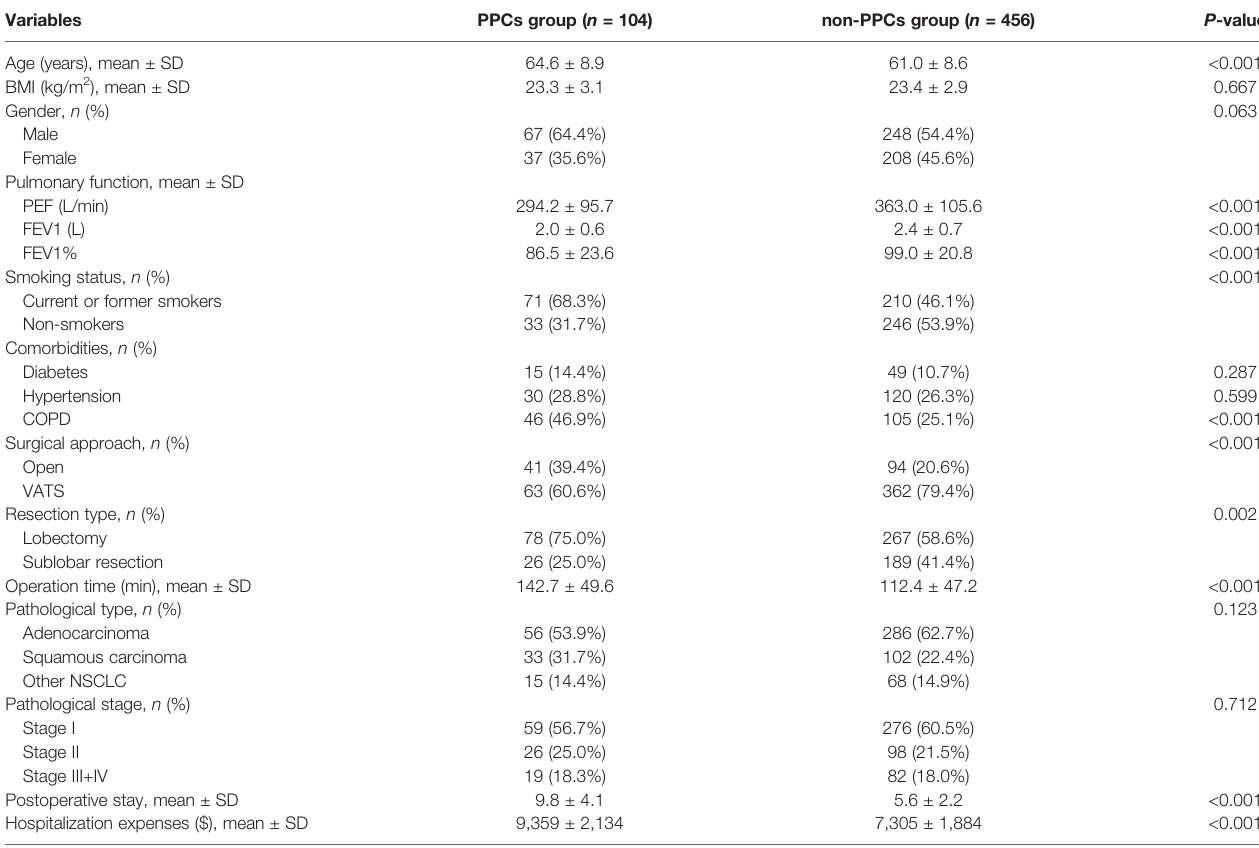
TABLE 1 | Baseline and clinical characteristics between the PPCs groups and non-PPCs